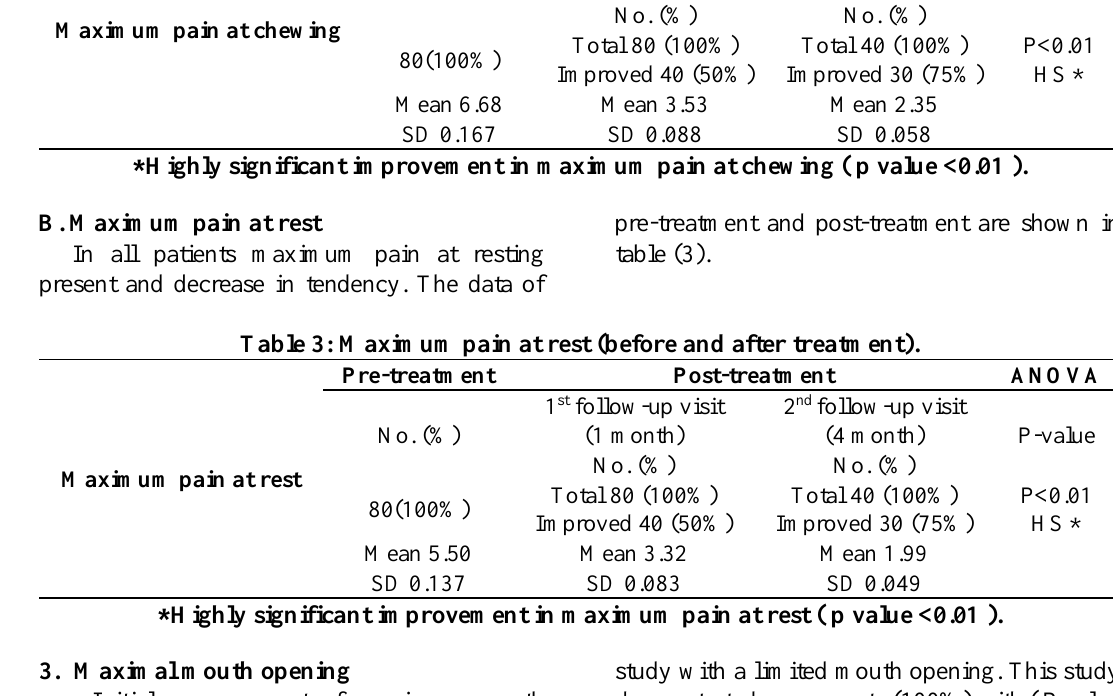
Maximum pain at chewing